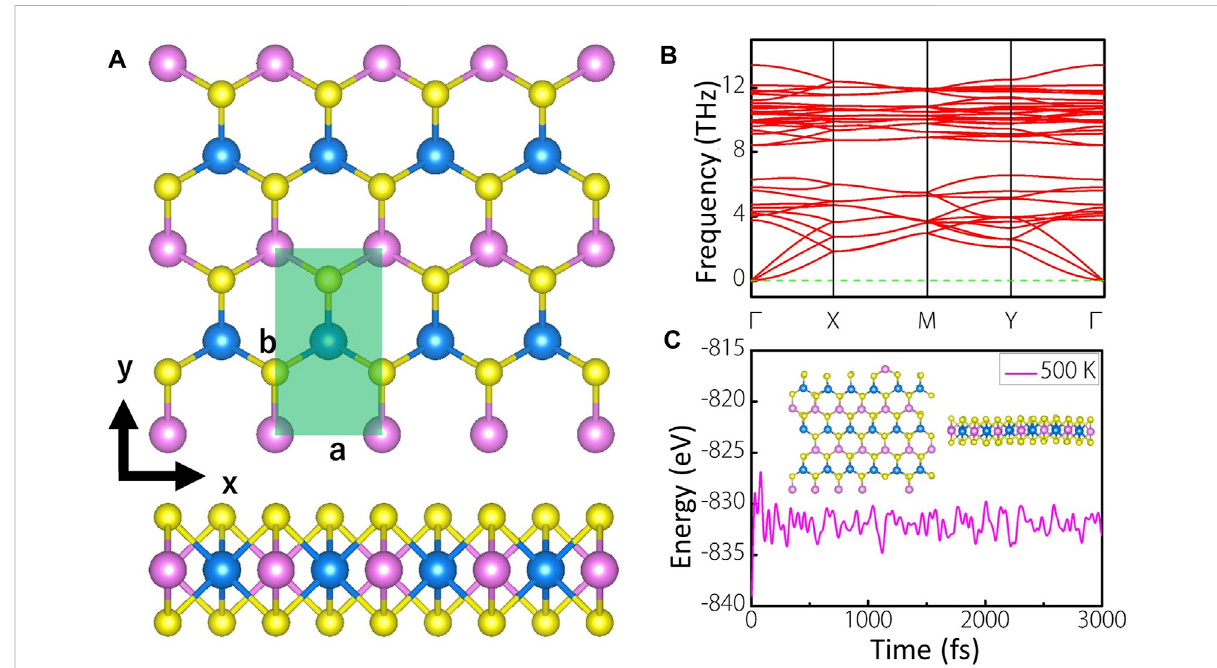
FIGURE 1 (A) Top and side views of MoWS 4 monolayer.The pink, blue, and yellow balls represent Mo, W, and S atoms, respectively.The lightgreenarea is the unit cell of MoWS 4 monolayer (B) Phonon spectra of MoWS 4 monolayer (C) Evolution of the total energy and a snapshot of MoWS 4 monolayer after a 3,000 fs AIMD simulations in vacuum at